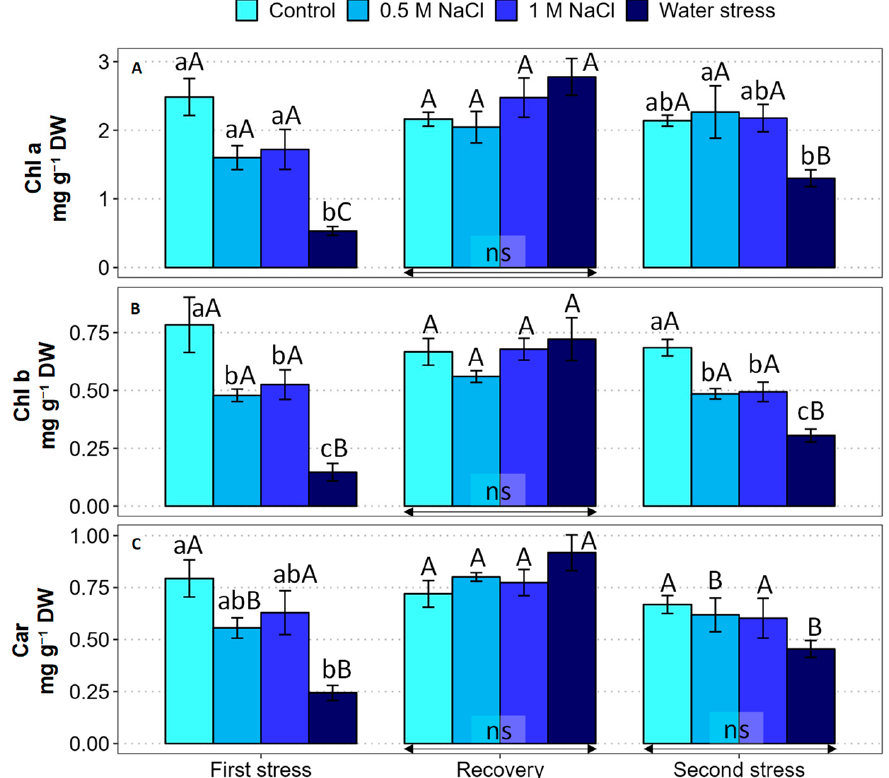
Figure 3. Effect of 30 days of stress treatment (First stress), followed by 15 days of watering with non-saline water (Recovery) and by additional 15 days of stress (Second stress) on the contents of photosynthetic pigments in Limonium angustebracteatum leaves. ( A ) Chlorophyll a (Chl a), ( B ) chloro- phyll b (Chl b), and ( C ) total carotenoids (Car). Different lowercase letters over the bars indicate significant differences between treatments (Control, 0.5 M NaCl, 1 M NaCl, and Water stress) for each sampling at p ≤ 0.05; ns: non-significant. Different uppercase letters indicate significant differences between the three sampling times (First stress, Recovery, and Second stress) for each treatment, at p ≤ 0.05; ns: non-significant. Vertical bars indicate standard error (n =